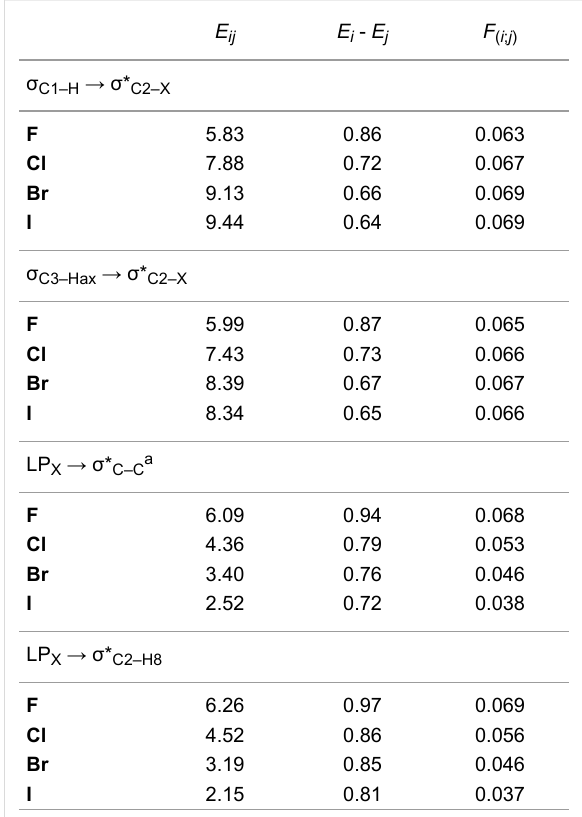
Table 5: Stabilization energy, E ij (kcal mol − 1 ), orbitals energy differ- ence E i − E j (a. u.) and Fock matrix elements F ( i ; j ) (a. u.) of main